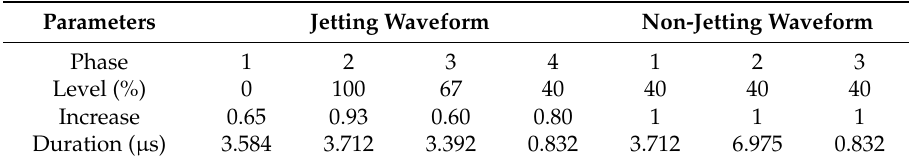
Table 2. Waveforms used during printing.